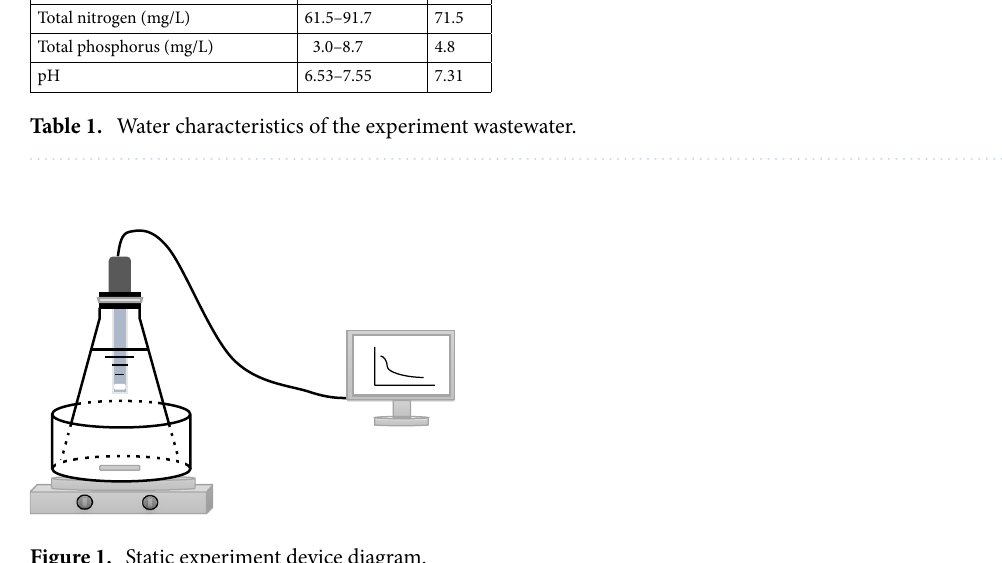
Figure 1. Static experiment device